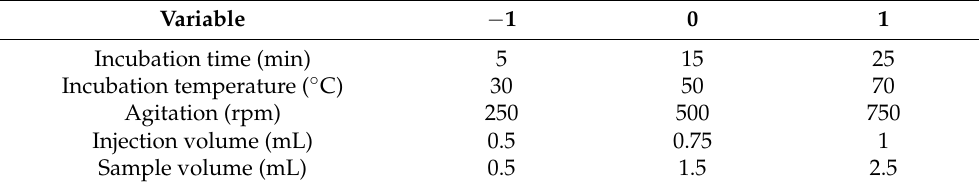
Table 3. Selected variable values and their coded and non-coded levels for the Box–Behnken design– response surface methodology